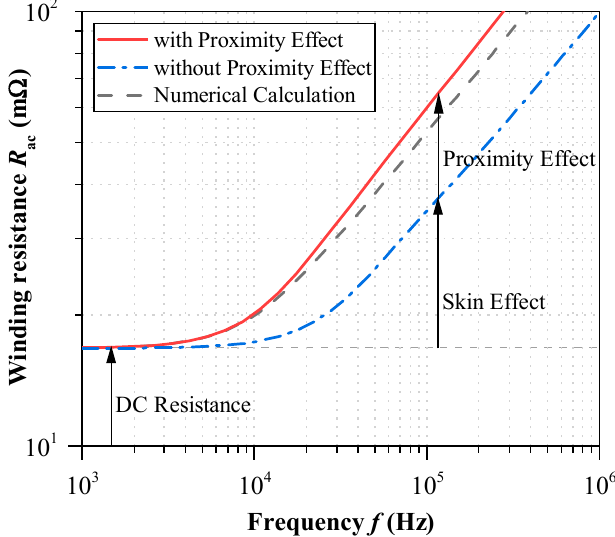
Figure 9. Frequency-dependent resistance R ac ( f ) of the winding for N PFC = 27 calculated using an analytical approach and numerical method.